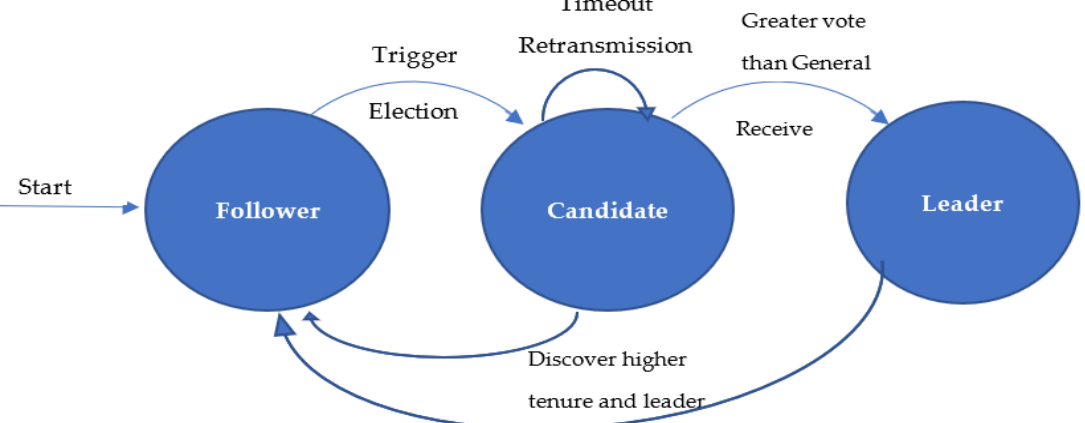
Figure 4. Working of the RAFT consensus.